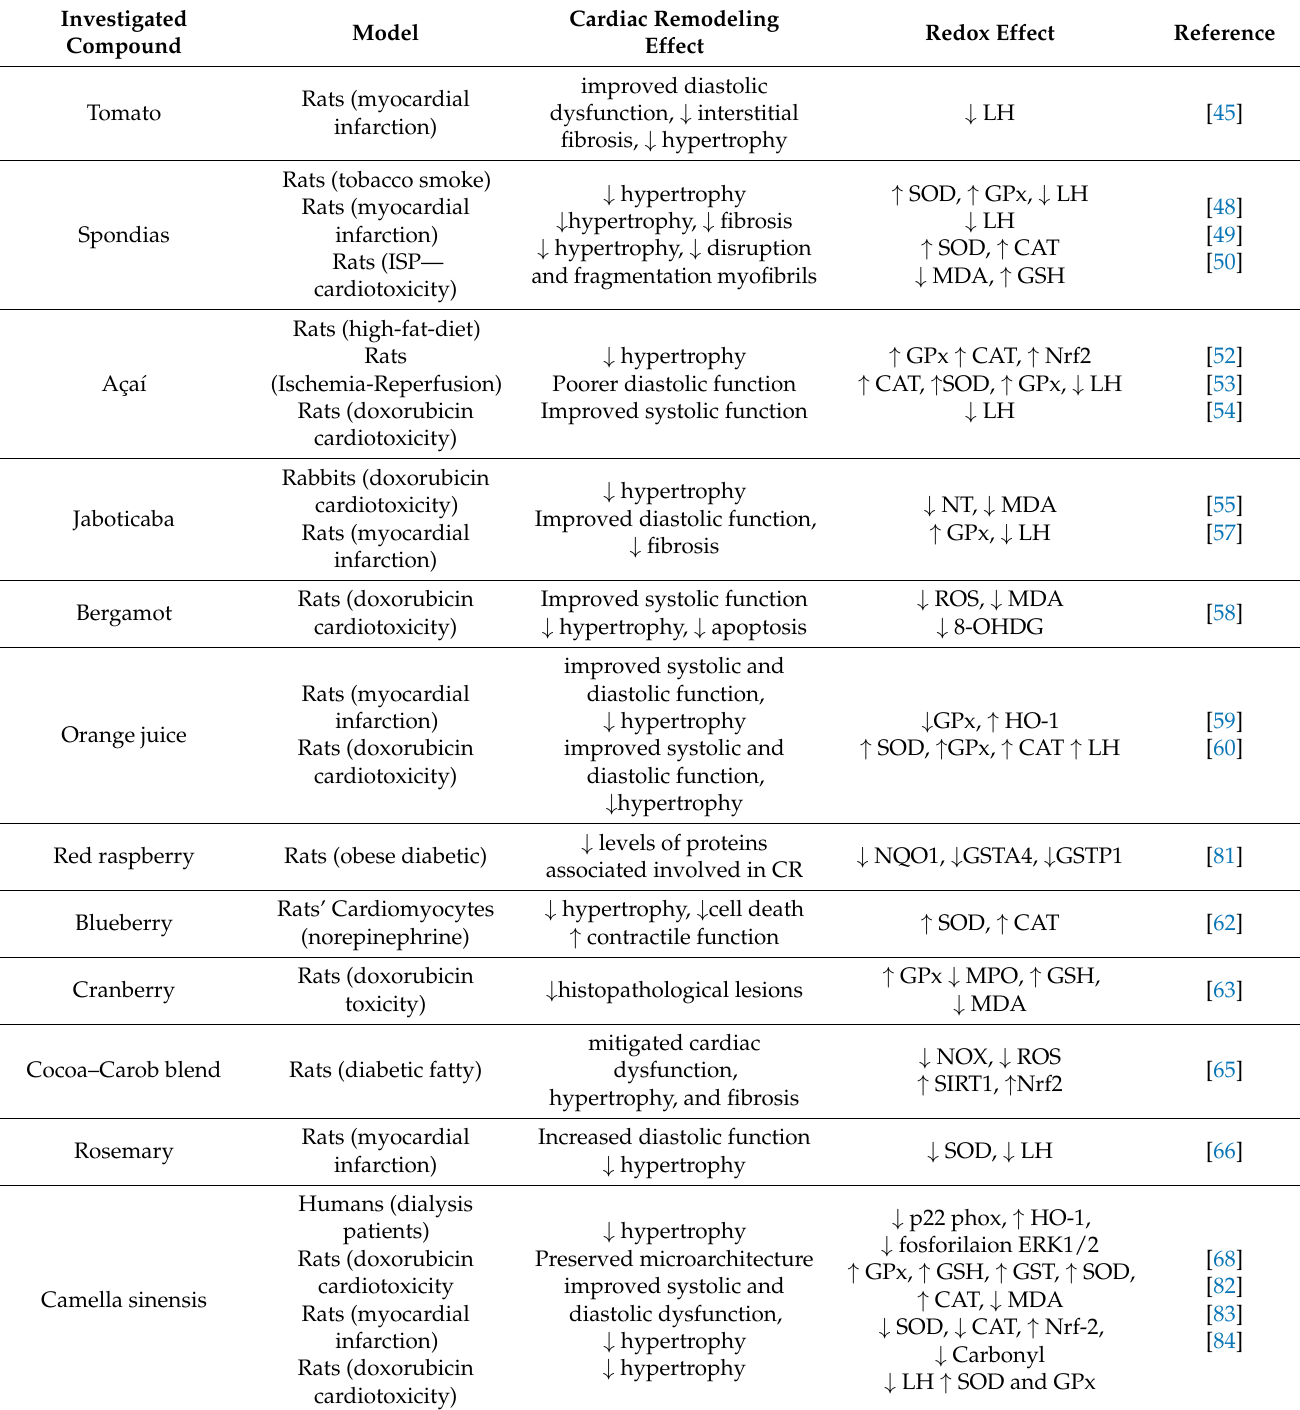
Table 2. Phytochemicals/phytonutrients investigated regarding their potential therapeutic antioxi- dant effects in cardiac